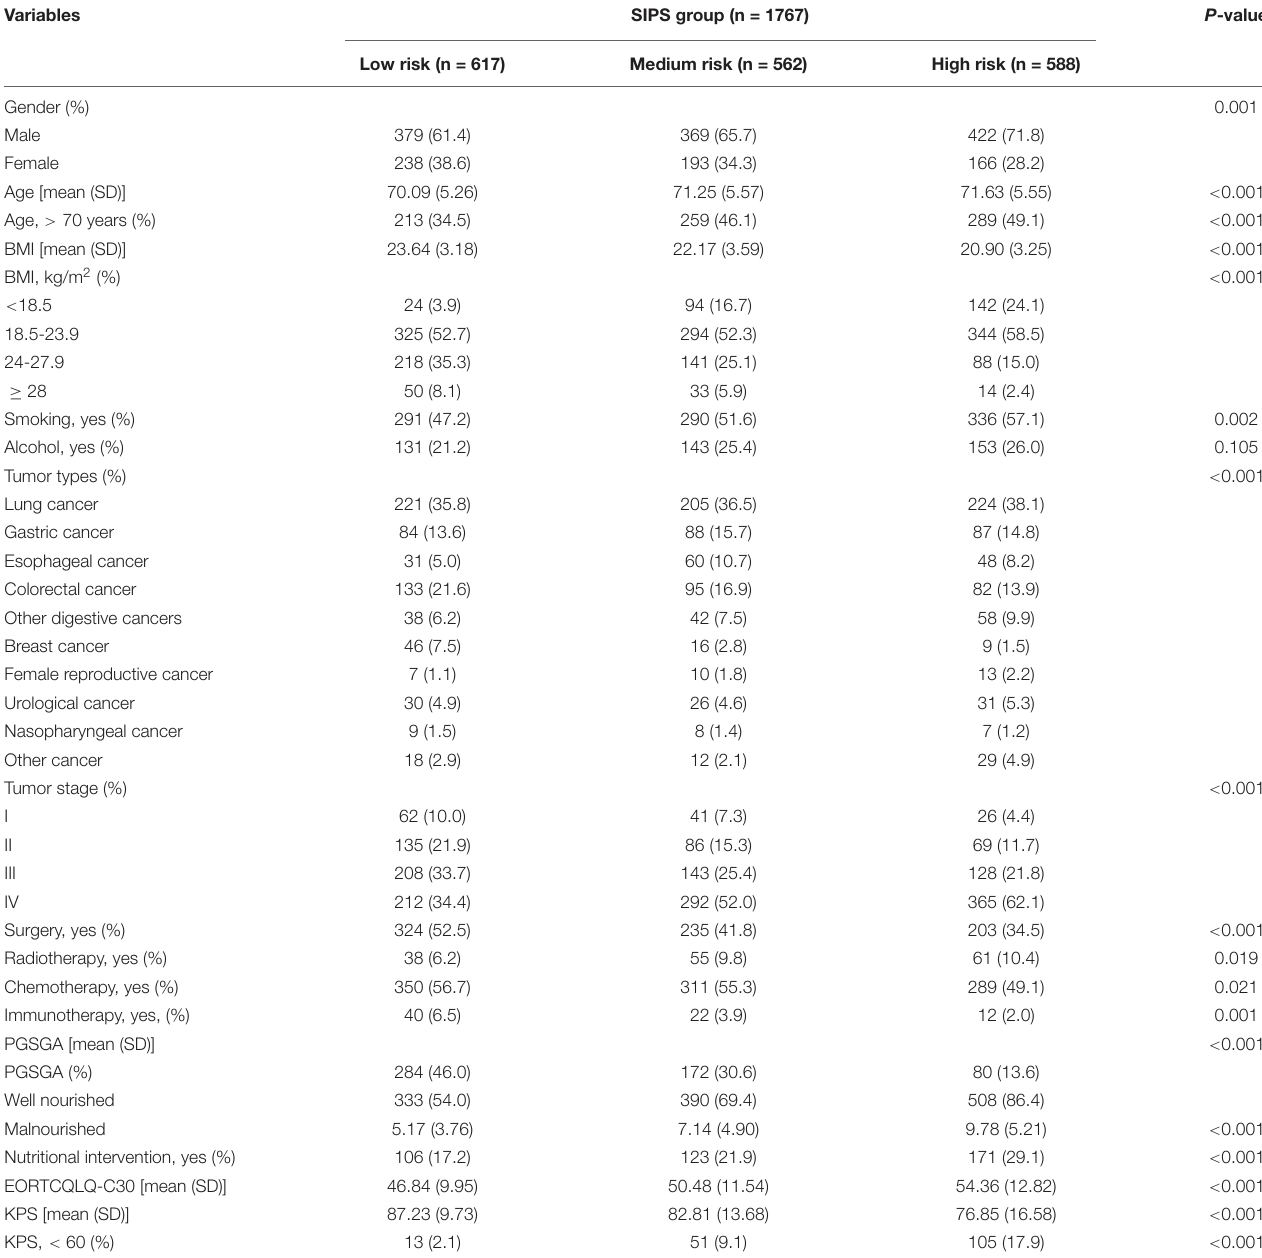
TABLE 3 | Baseline characteristics stratified by